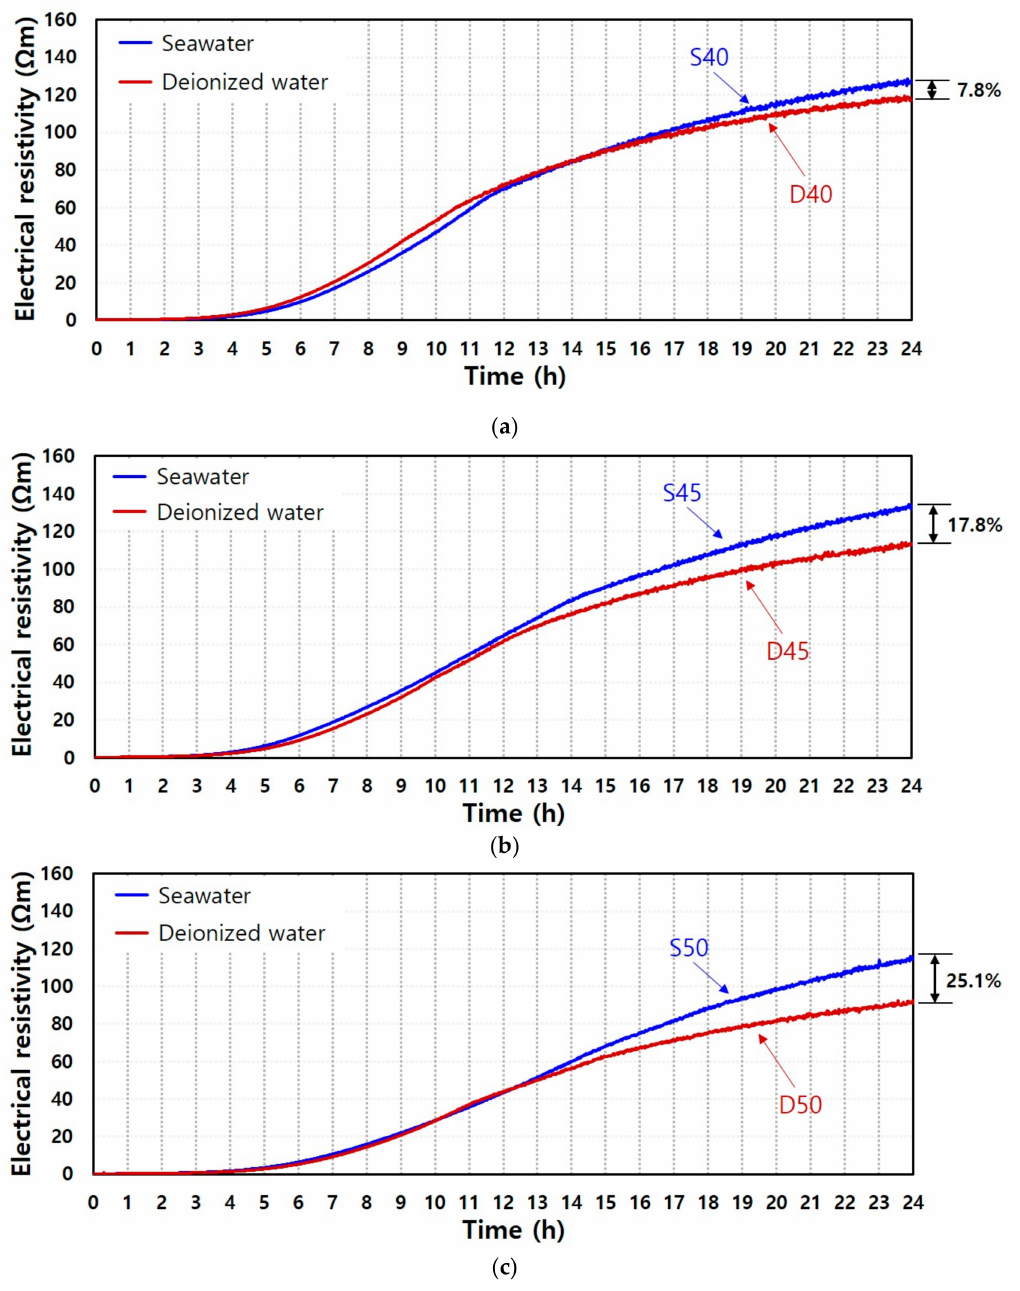
Figure 4. Comparison of measured electrical resistivity of seawater-mixed and deionized water-mixed AAS pastes with di ff erent a / b ratios: ( a ) 0.4, ( b ) 0.45, and ( c )